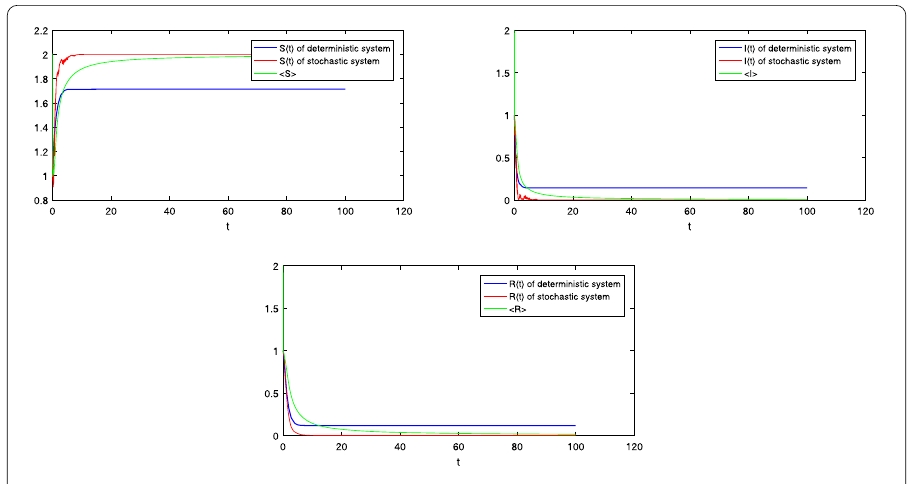
Figure 5 Comparison of the deterministic system and the stochastic system, with (cid:2) = 2, α = 0.2, β = 2, a = 1, μ = 1, r